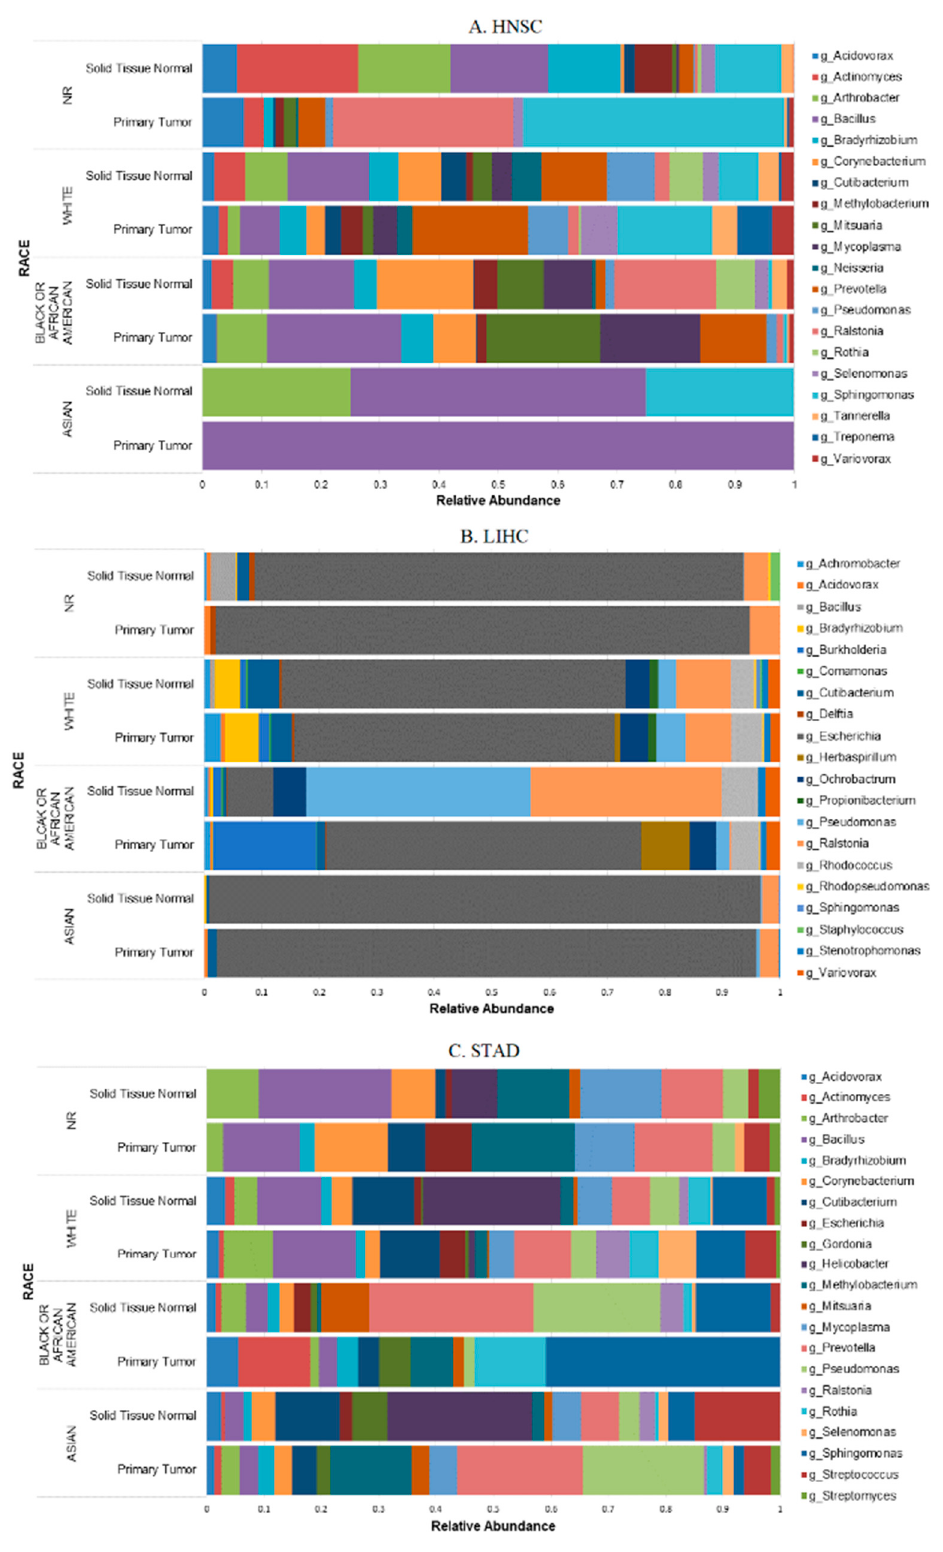
Figure 1. Microbial composition stratified by sample type and race at the genus level in HNSC ( A ), LIHC ( B ), and STAD ( C ) cancer cohorts. NR: not reported race.